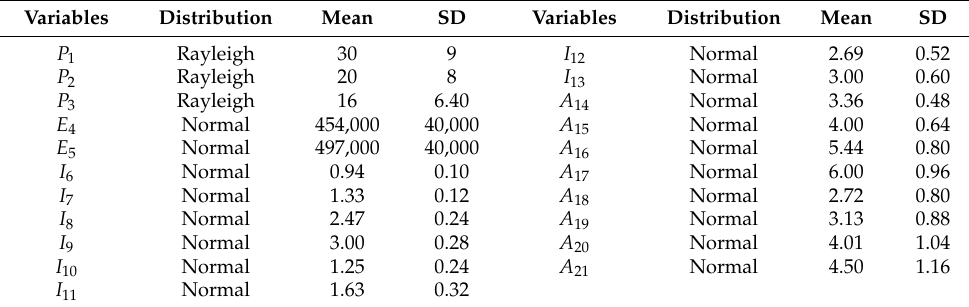
Table 13. Values of g 0 , D , S i and S tot